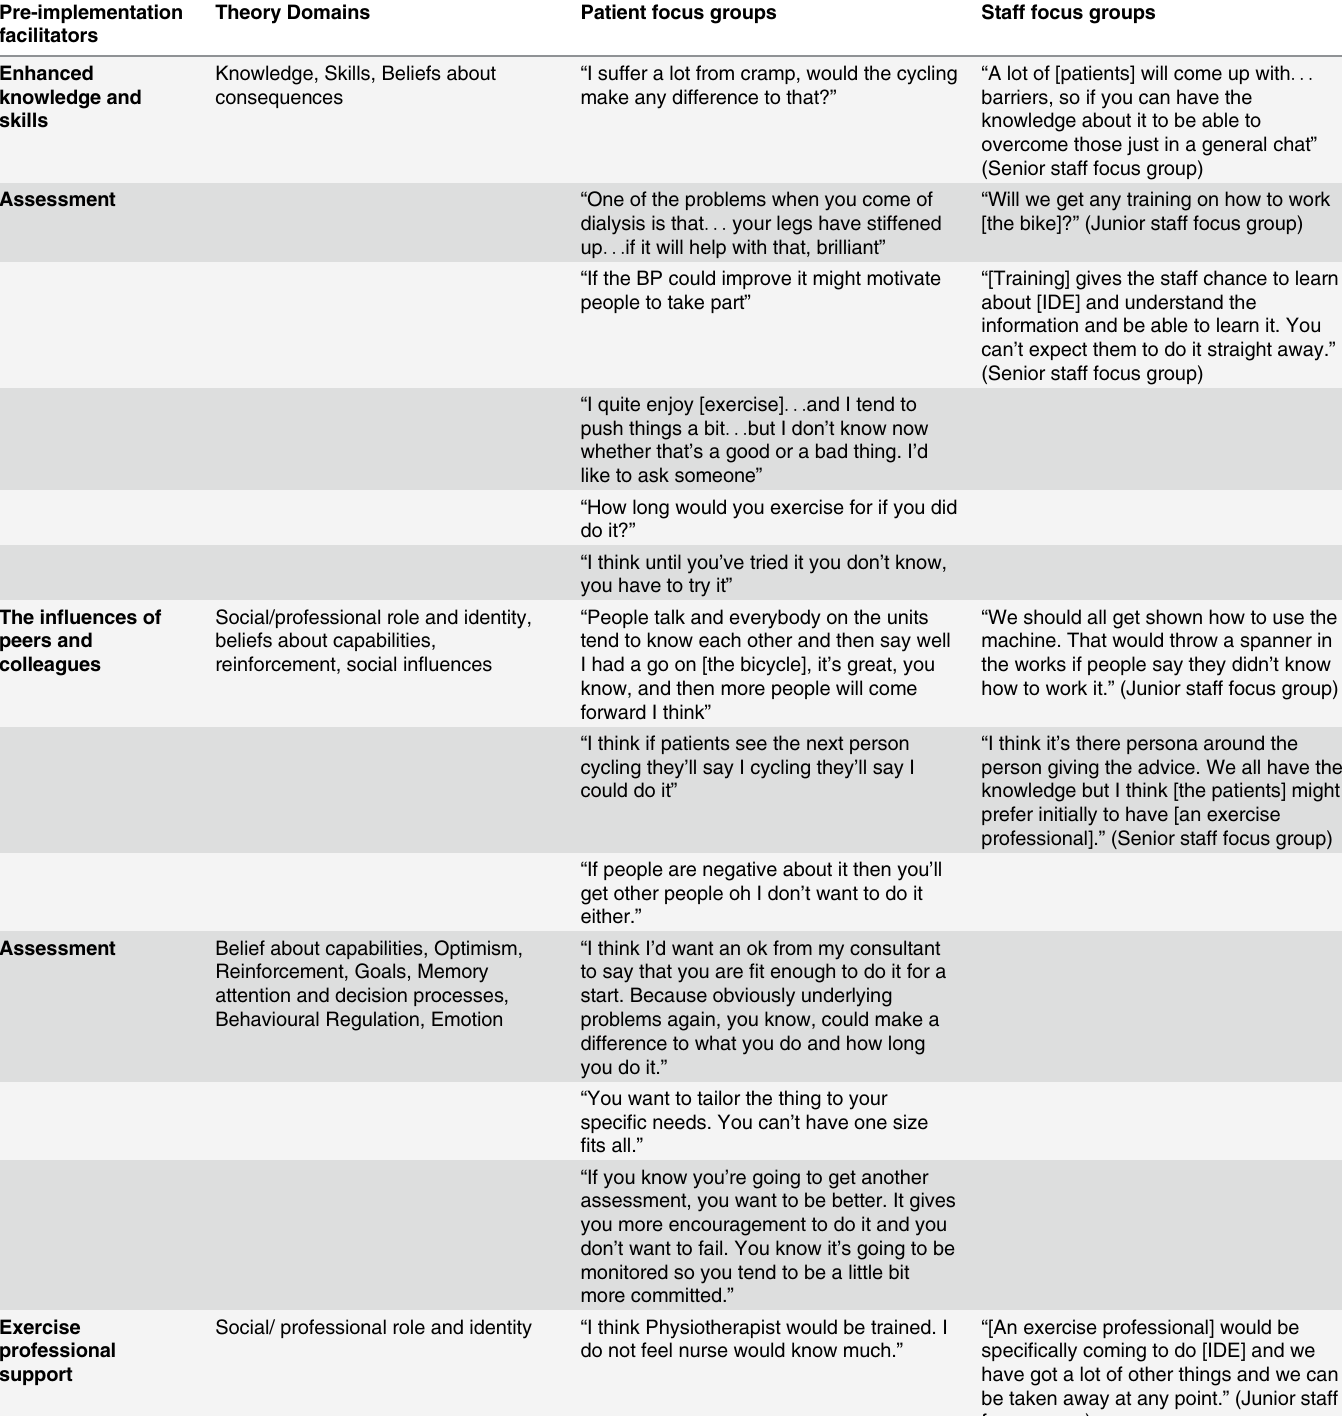
Table 3. Pre — implementation IDE facilitators, as identified by patients and